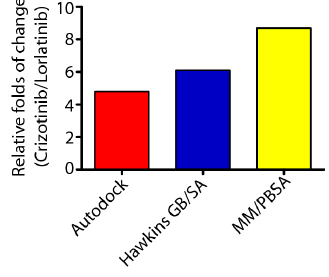
Figure 3. Energy decomposition of ALK–crizotinib and ALK–lorlatinib complexes. The binding energy of crizotinib and lorlatinib to ALK were calculated by AutoDock Vina 1.1.2, Hawkins generalized Born surface area (Hawkins GB/SA), and molecular mechanics Poisson–Boltzmann surface area (MM/PBSA) methods. The relative folds of energy change were defined as the folds of binding energy decrease from lorlatinib to crizotinib.